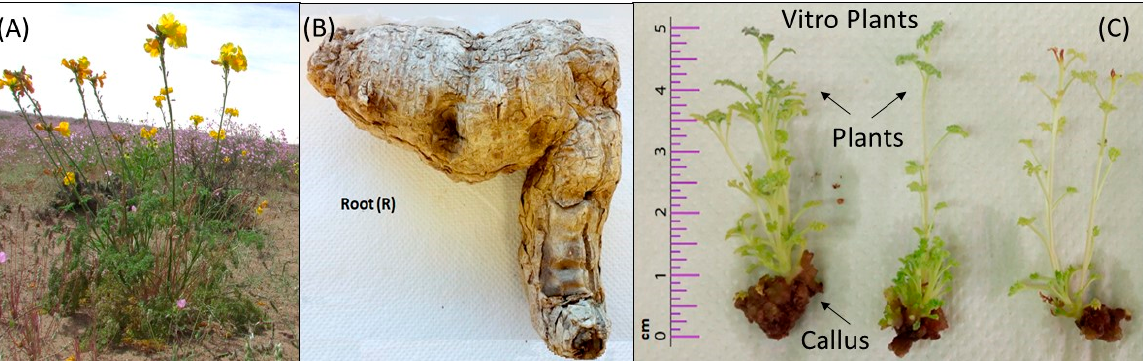
Figure 1. Atacama Desert wild Argylia radiata plant ( A ), its tuberous root ( B ) and vitroplants after five weeks of growth in MS media supplemented with 0.5 mg L − 1 of BAP to promote callus formation ( C ).